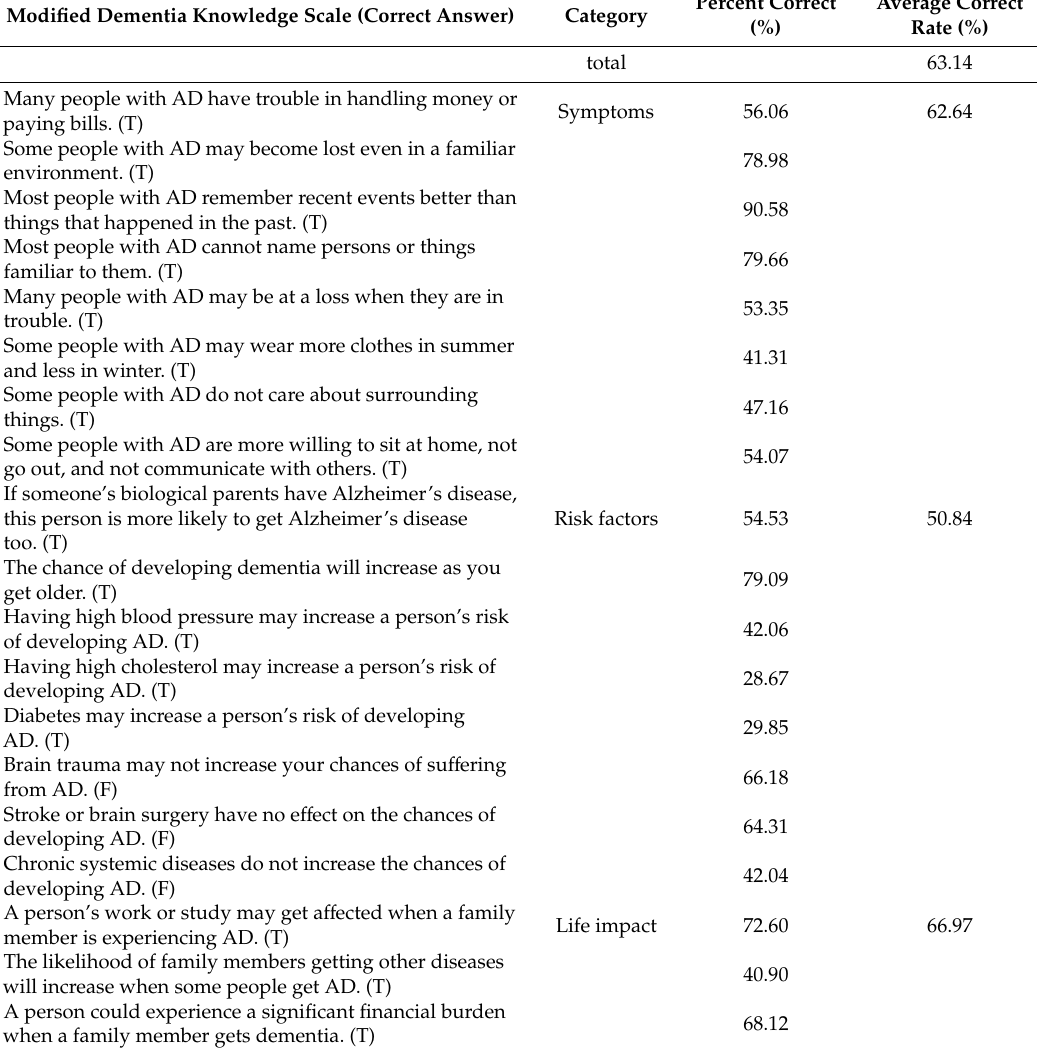
Table 2. The percentage of correct answers for questions regarding the knowledge about dementia. T: true, F: